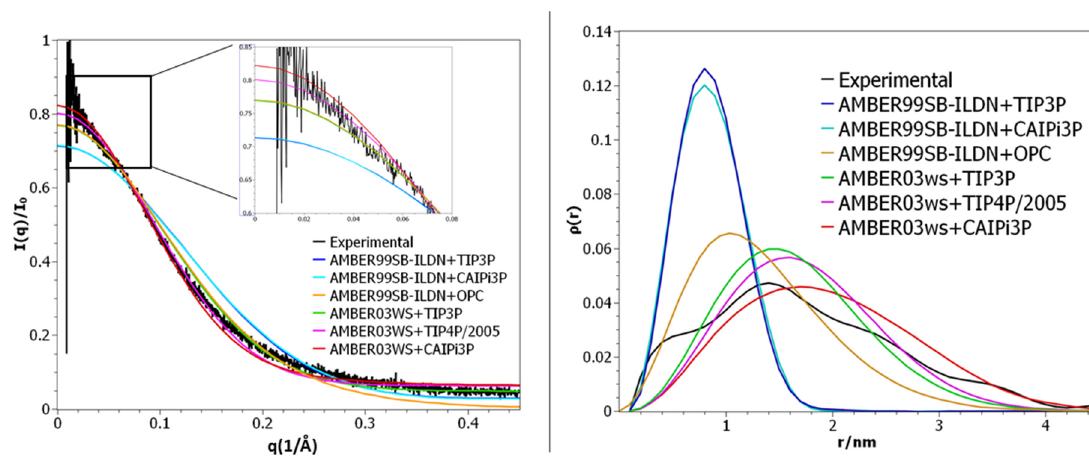
Figure 4. ( Left panel ) Small-angle X-ray scattering (SAXS) intensities. ( Right panel ) Pair distance distribution function for R/S peptide SAXS.